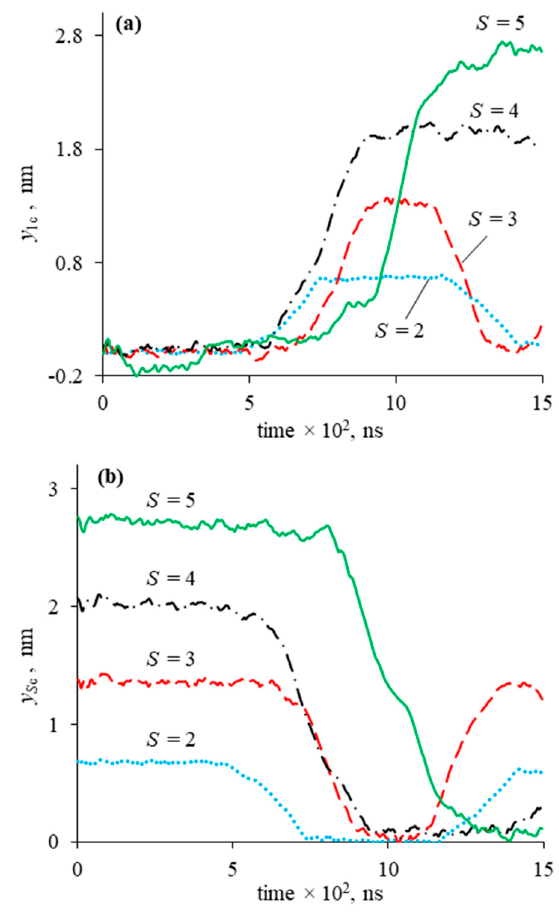
Figure 3. Time dependence of the y-coordinates of the centers of mass of the first ( a ) and last ( b ) nanotori at S = 2,…,5.